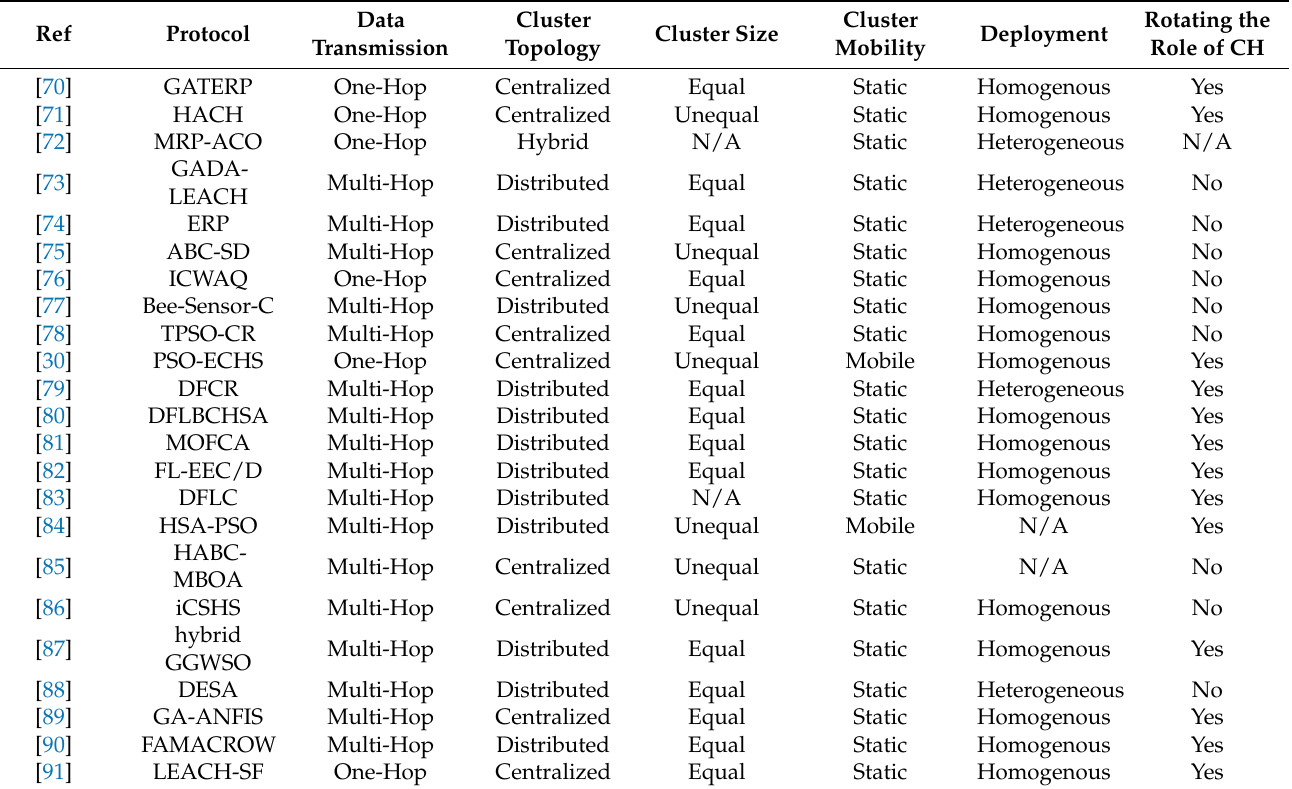
Table 2. Overview of the selected articles.